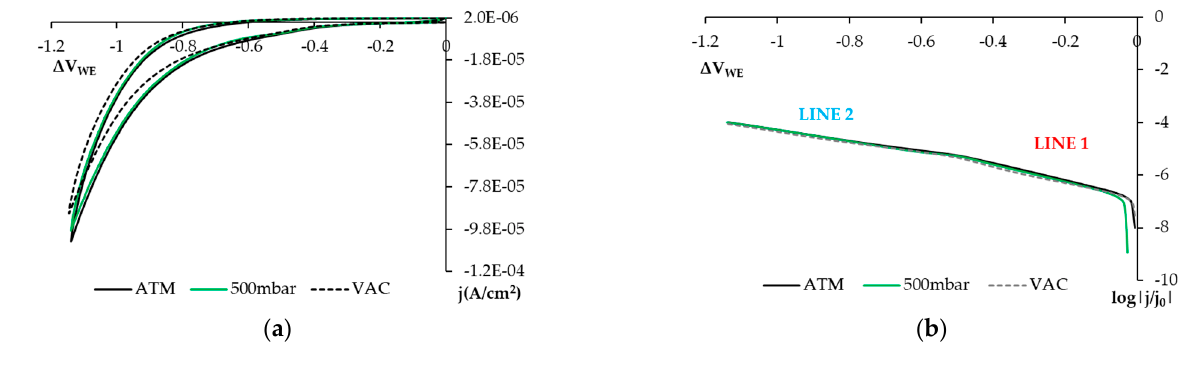
Figure 9. Results of cyclic voltametry with the SS sensor embedded in a hardened concrete sample of w/c = 0.6 under atmospheric conditions (black solid line, ATM), under partial air pressure condition, 500 mbar (green solid line, 500 mbar) and VAC conditions, with practically no O 2 (dashed line, VAC) using the 2-electrode technique. ( a ) Voltagram in which ohm drop is corrected. ( b ) Voltagram of cathodic sweeping represented logarithmically that corresponds to Figure a.